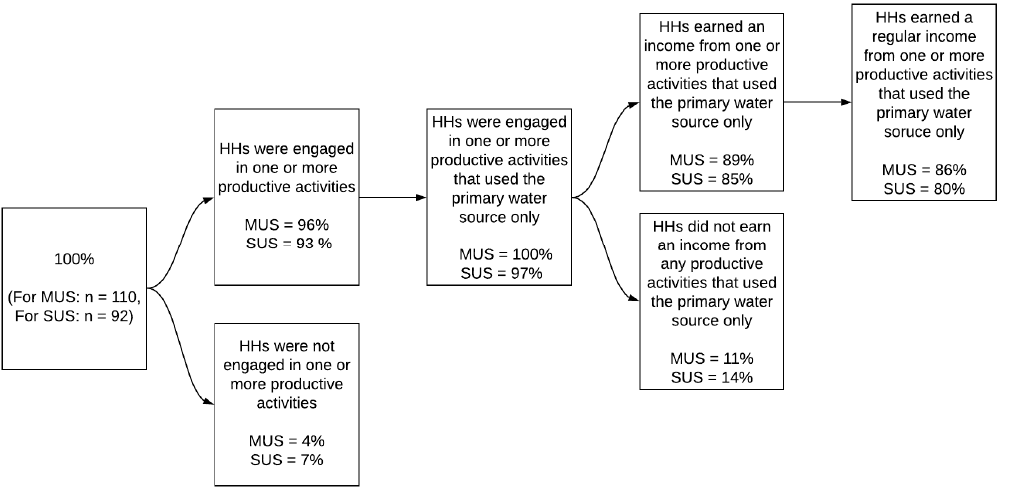
Figure 3. Extent of productive activity of MUS and SUS.